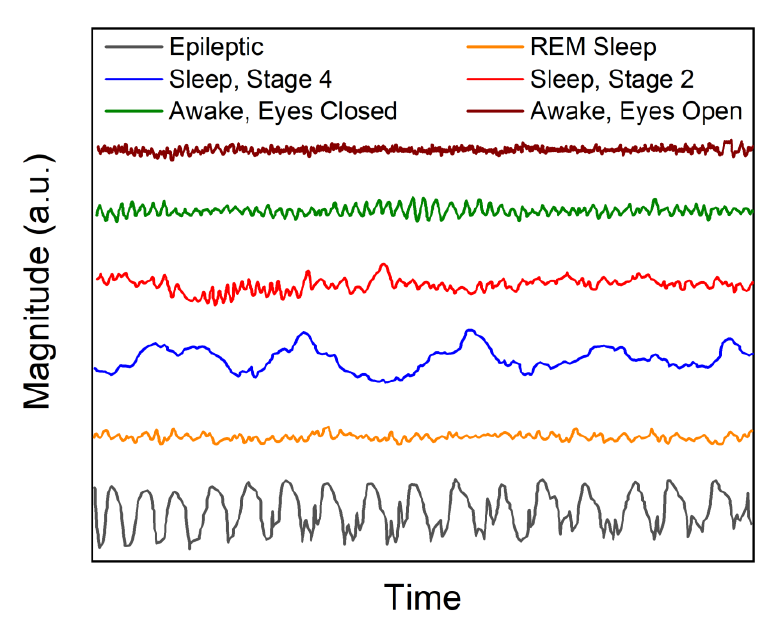
Figure 6. Electroencephalographic recordings during different brain states in humans, which include awake with eyes open, awake with eyes closed, sleep stage 2, sleep stage 4, rapid eye movement (REM) sleep state, and epileptic seizure (adapted from Reference [92]).